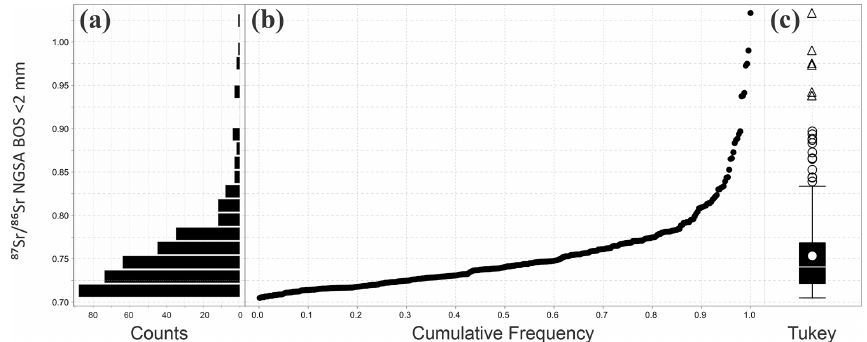
Figure 3. Univariate distribution of the 87 Sr / 86 Sr data ( n = 357) from the northern Australia Sr isotope study area: (a) histogram (20 bins, 0.016 wide); (b) cumulative frequency plot; and (c) Tukey box plot (the solid white dot shows the mean, circles denote outliers, and triangles represent extreme outliers) (Tukey, 1977). The sample medium is the < 2mm fraction of NGSA bottom outlet sediment (BOS) or equivalent (see the text for further